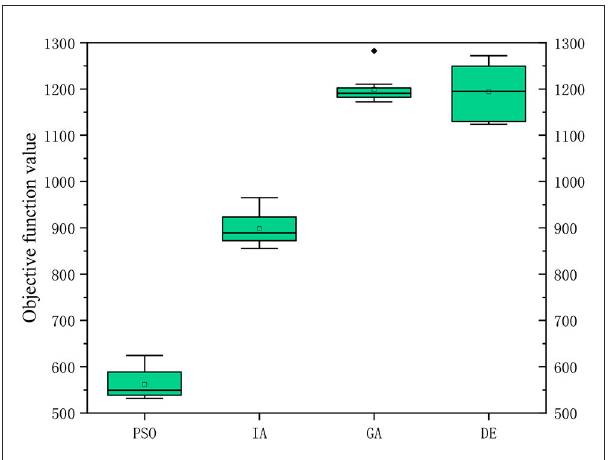
FIGURE6 Computational accuracy comparison of the four algorithms.